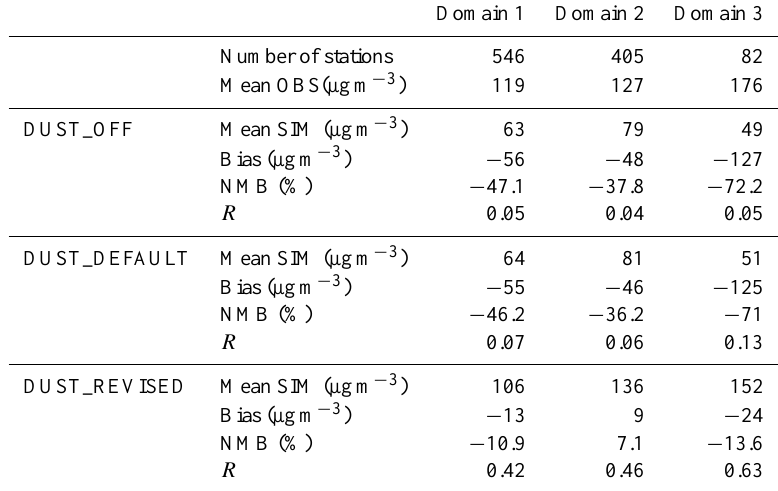
Table 4. Model performance for hourly PM 10 concentrations. See text for abbreviation